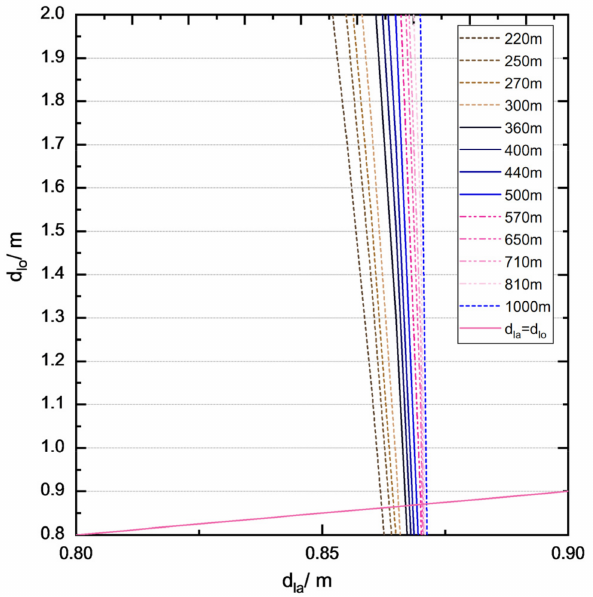
Figure 3. Relationship of lateral ( d la ) and longitudinal ( d lo ) alert limits corresponding to the different highway radius of circular curve r R